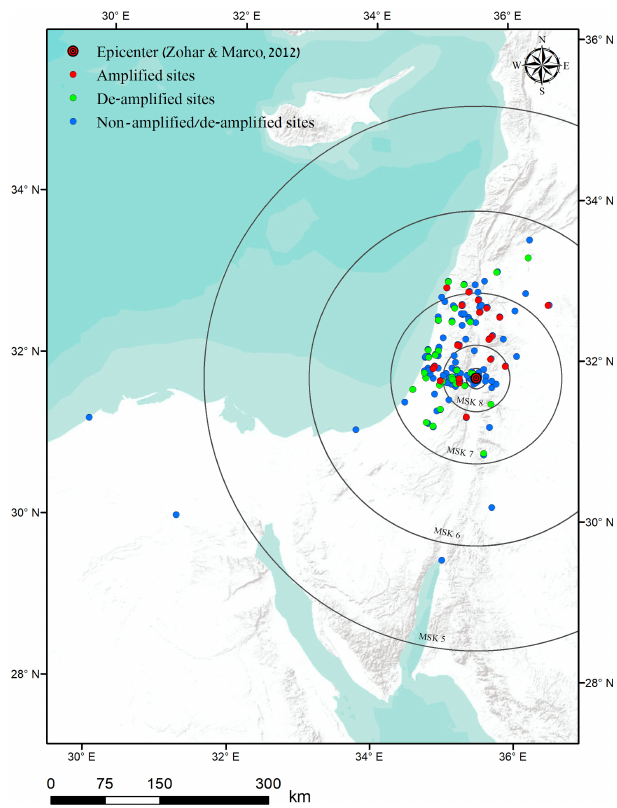
Figure 4. Isoseismal map. The epicentral location is in red and black circles. Red and green dots are suspected amplified or de- amplified sites (respectively). Blue dots are sites which have MSK values expected from the attenuation equation (with a 60% predic- tion boundary).